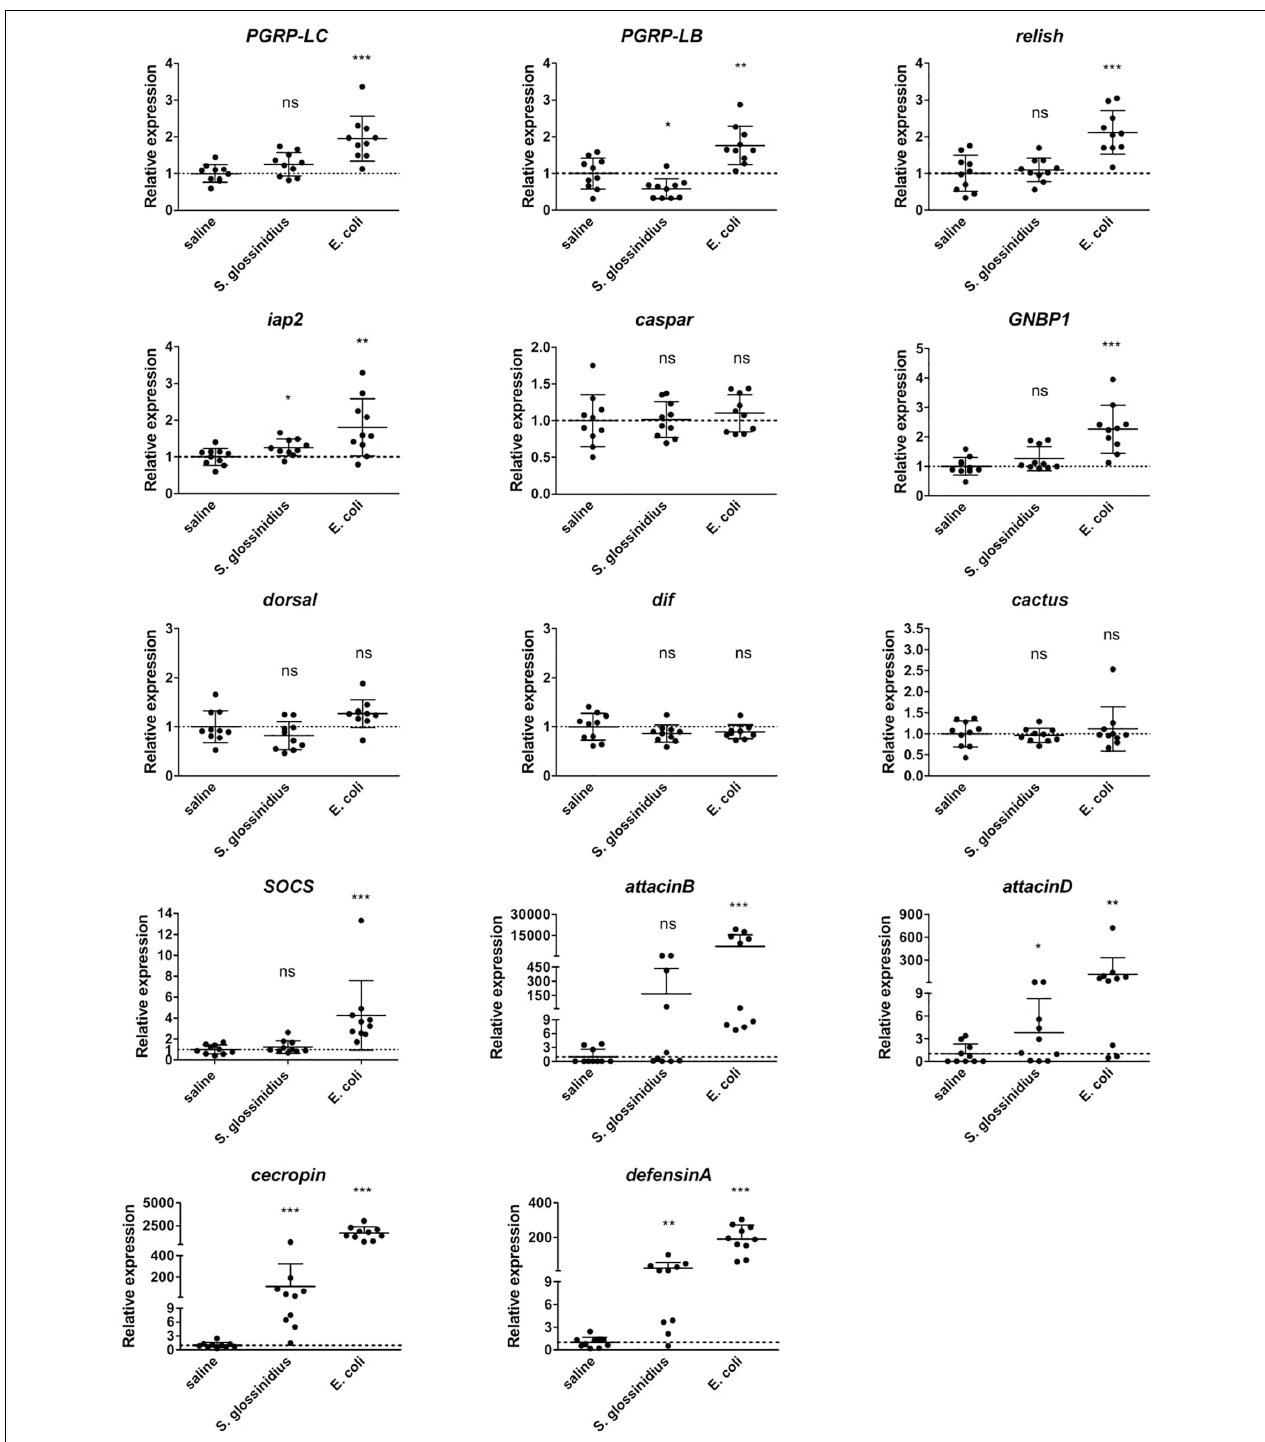
FIGURE 4 | Relative expression levels of innate immunity-related genes obtained by qRT-PCR analysis in S. glossinidius -free ( Gmm Sod − ) flies exposed to 10 6 CFU Sodalis glossinidius or 10 5 CFU E. coli and their corresponding injection-control with sterile saline. Bacterial exposure was performed on day 8 post-eclosion via intrathoracic microinjection as well as per os and total RNA was extracted after 48 h. The expression levels were normalized against the two tsetse reference genes β -tubulin (GMOY000148) and pleiotrophic regulator 1 (GMOY006161). Expression in each abdomen is plotted relative to the mean of the injection-control group. Values are represented as the mean with the standard deviation. N = 10 independent replicates per group. ∗ p -value < 0.05, ∗∗ p -value < 0.01, ∗∗∗ p -value < 0.001; Dif, dorsal-related immunity factor; GNBP1, gram-negative binding protein 1; iap2, inhibitor of apoptosis 2; ns, not significant; PGRP, peptidoglycan recognition protein; SOCS, suppressor of cytokine